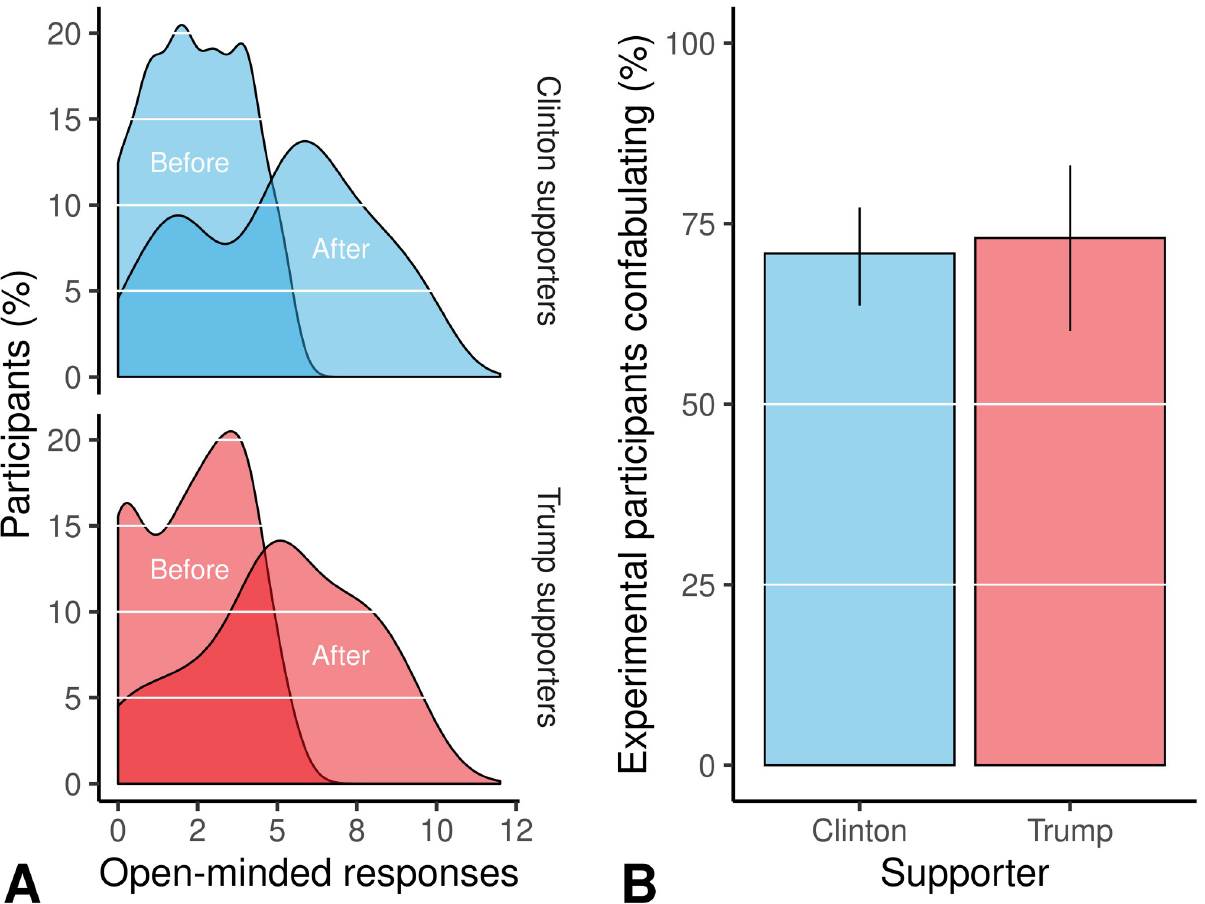
Fig 4. Frequency of “open-minded” responses and confabulation rates in the experimental group. As in Experiment 1, the manipulation made it appear as if the participants had provided more open-minded responses (A); they then explained the reasons behind their original views or the manipulated ones (B). We saw similar rates for both Clinton and Trump